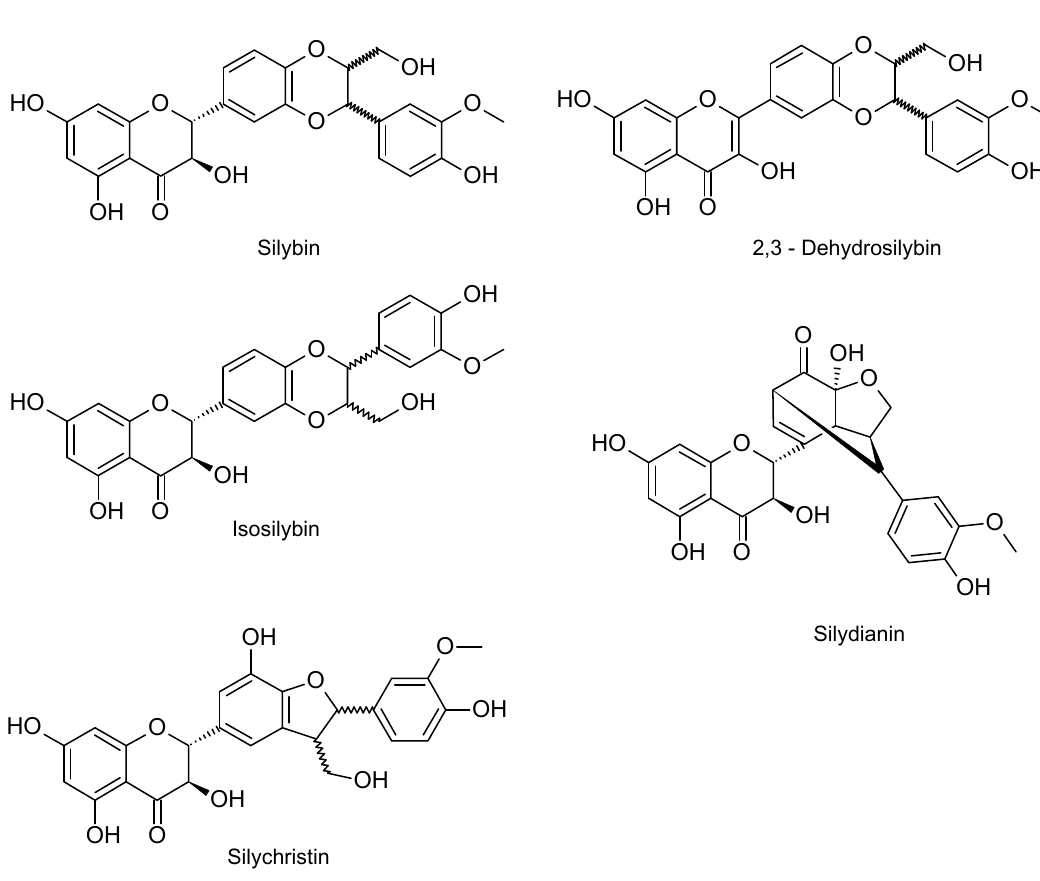
Figure 1. Structure of silymarin´s flavonolignans.